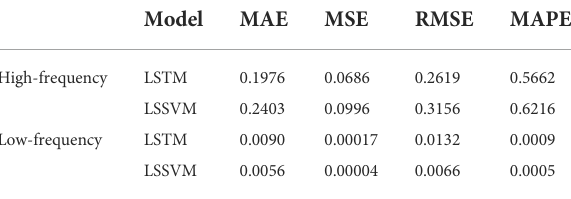
TABLE 1 Comparison of two prediction models using different